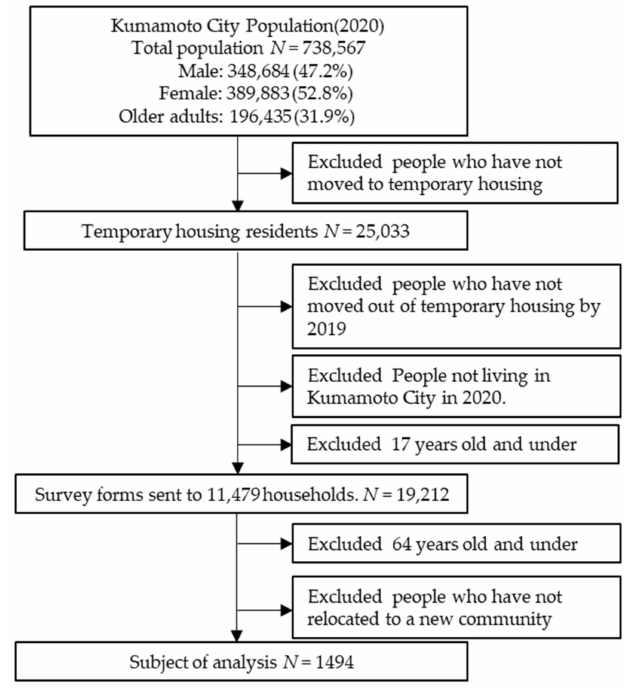
Figure 1. Population and data